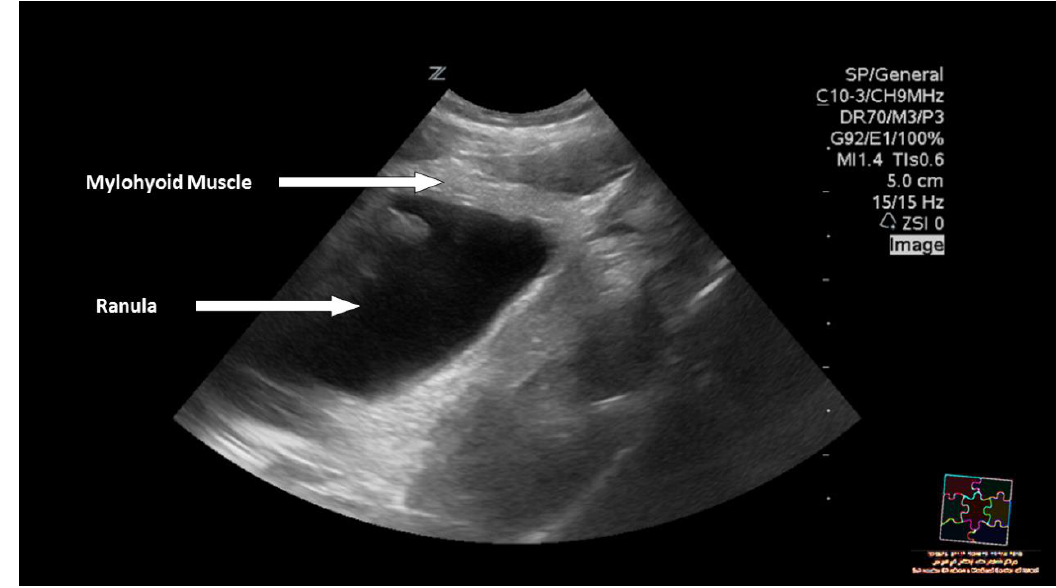
Figure 2. The ultrasonographic image, demonstrating the isolated ranula without extravasation through the mylohyoid